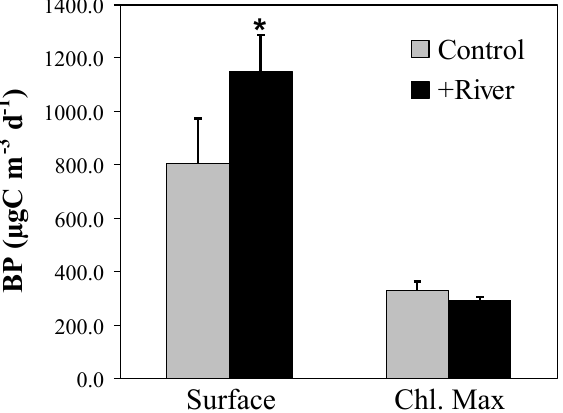
Fig. 6. Bacterial production (µgCm − 3 d − 1 ) after 48h incubations without (grey columns) and with (white columns) additions of 0.2µm-filtered water from the Mackenzie River (10%, vol:vol). Asterisk represent significant differences ( p <